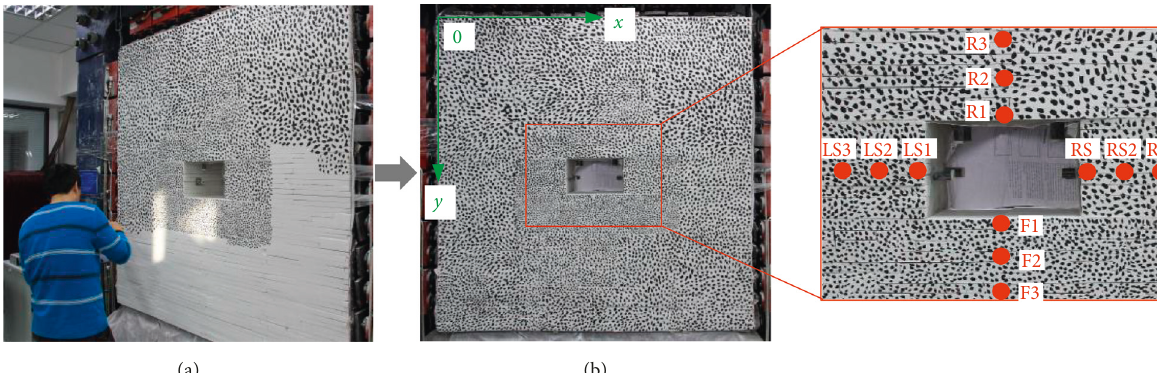
Figure 3: Photos of DIC displacement measurement; (a) spot making; and (b) schematic diagram of displacement field measurement range and layout of displacement and strain monitoring points.